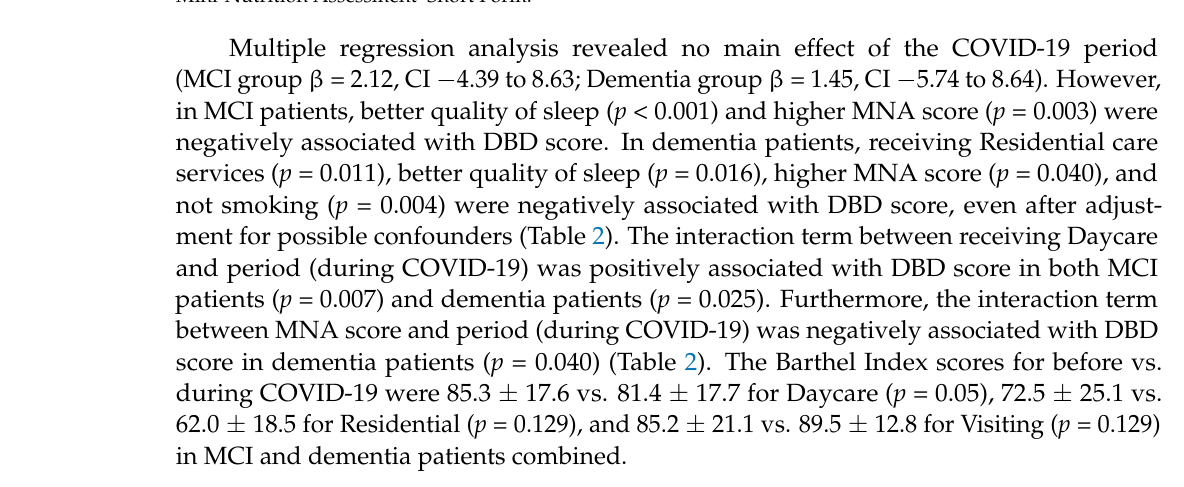
Table 2. Association of the Dementia Behavioral Disturbance (DBD) scale with care services and lifestyle factors in MCI and dementia patients.